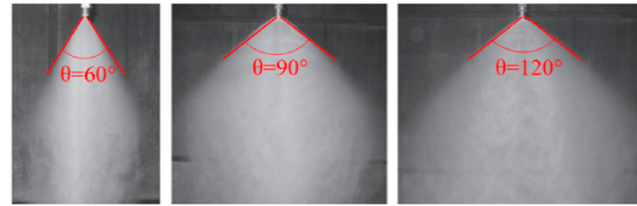
Figure 19. Nozzle spray angles for fire testing [20].